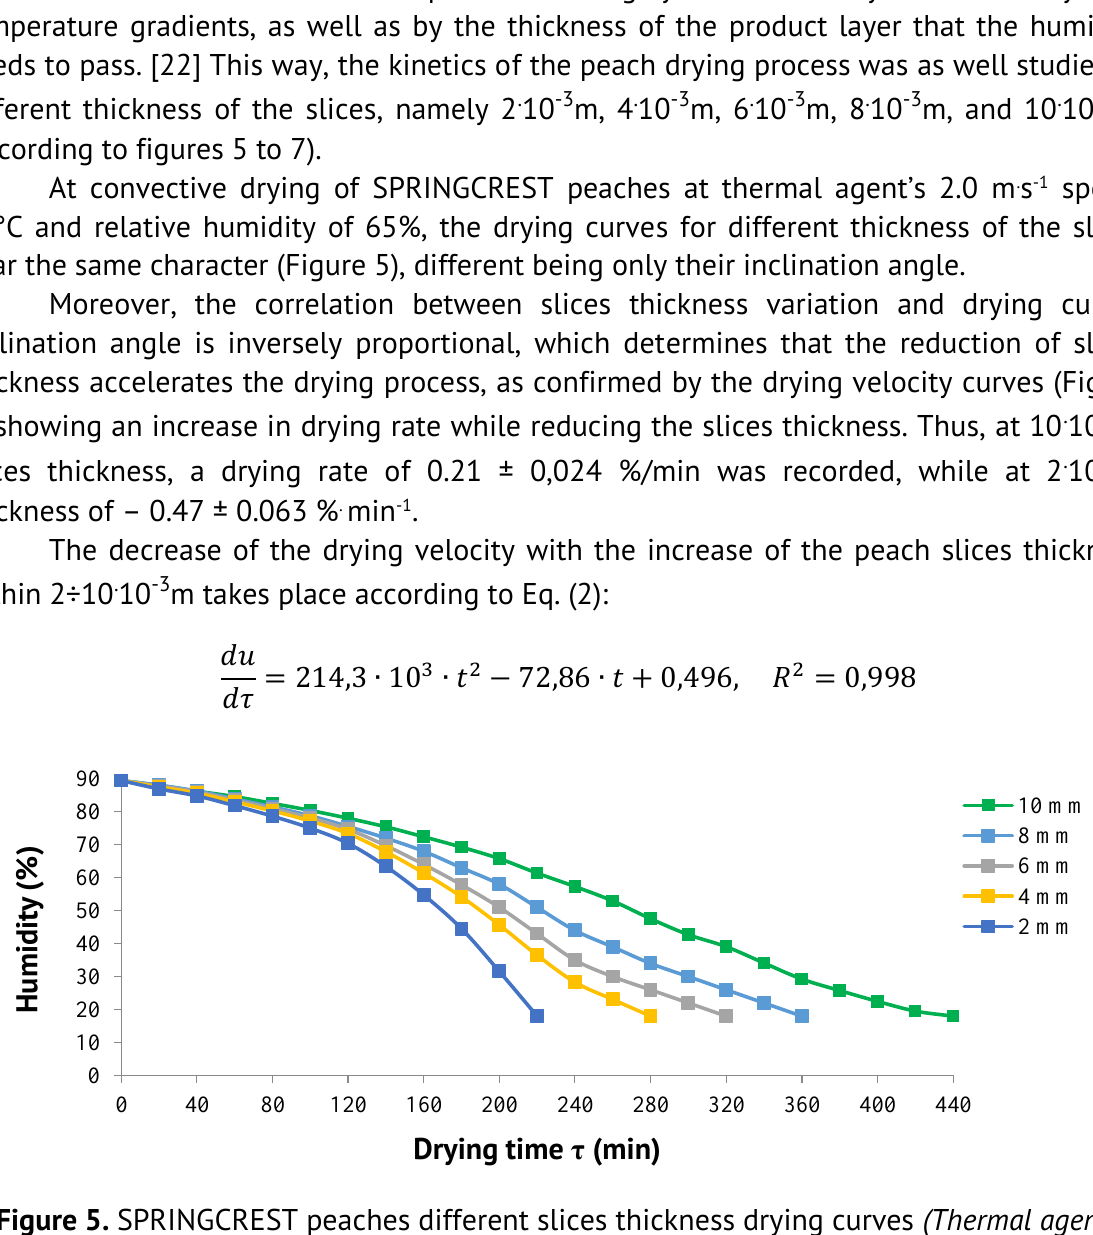
Figure 5. SPRINGCREST peaches different slices thickness drying curves (Thermal agent velocity 2.0 m . s -1 , thermal agent relative humidity 65.0%, thermal agent temperature